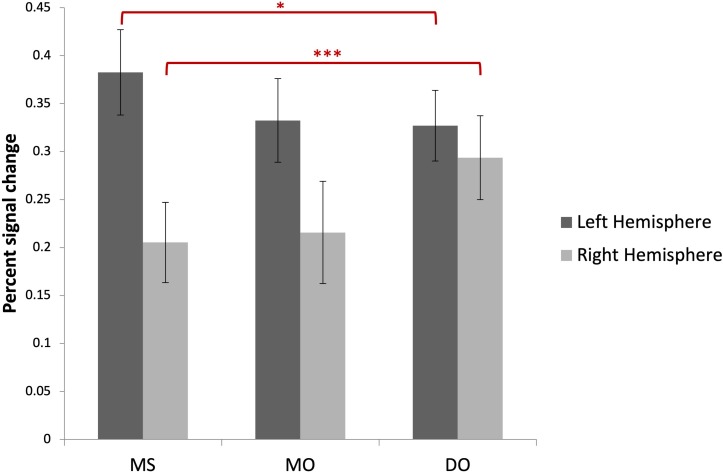
Percent signal changes computed on an anatomically defined set of ROIs (inferior frontal and precentral gyri, SMA, superior and middle temporal gyri as well as inferior and superior parietal cortex), in left and right hemispheres, for the MS, MO, and DO conditions. In these ROIs, from MS to DO, a significant decrease (∗) is observed in left hemisphere activation associated with a significant increase (∗∗∗) in right hemisphere recruitment.